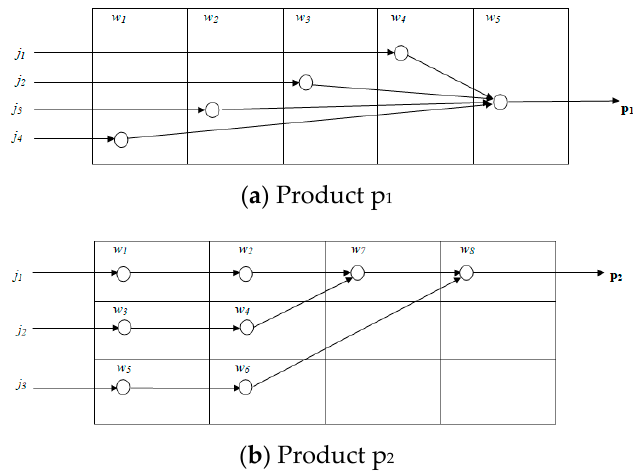
Figure 1. Assembly job-shop process operations.